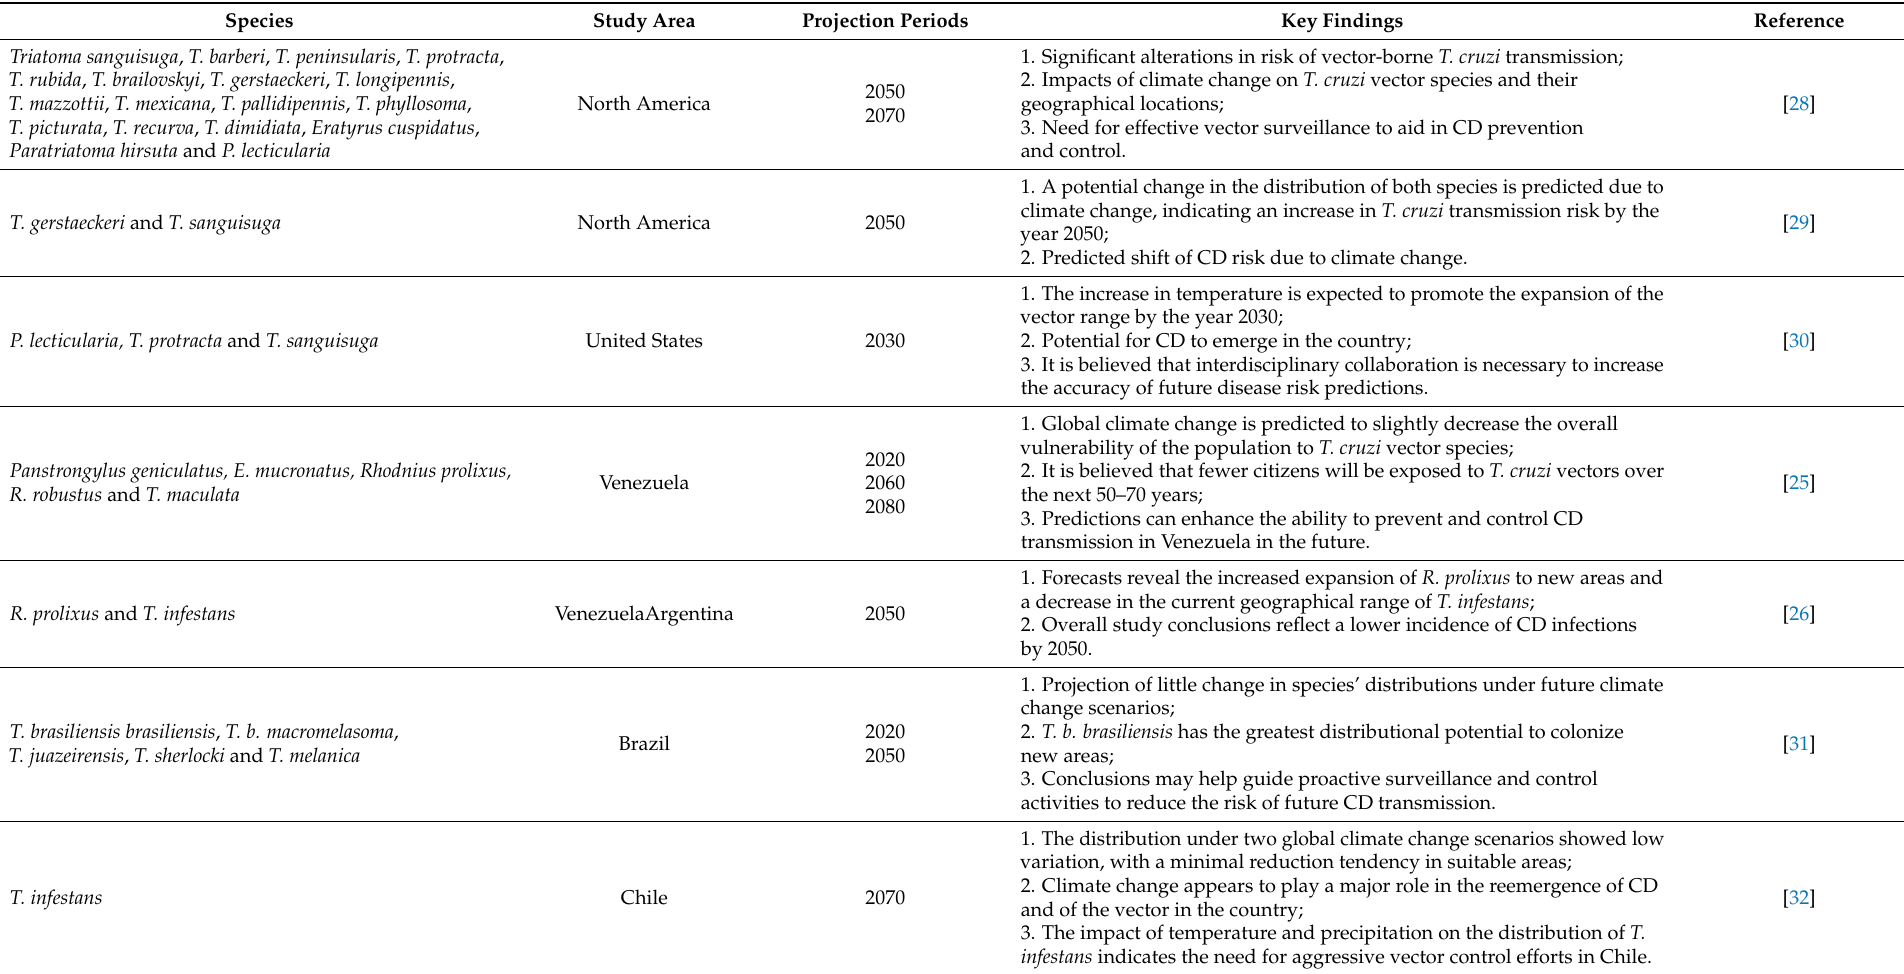
Table 1. Potential impact of climate change on the geographical distribution of triatomines and in the vectorial transmission dynamics of T. cruzi